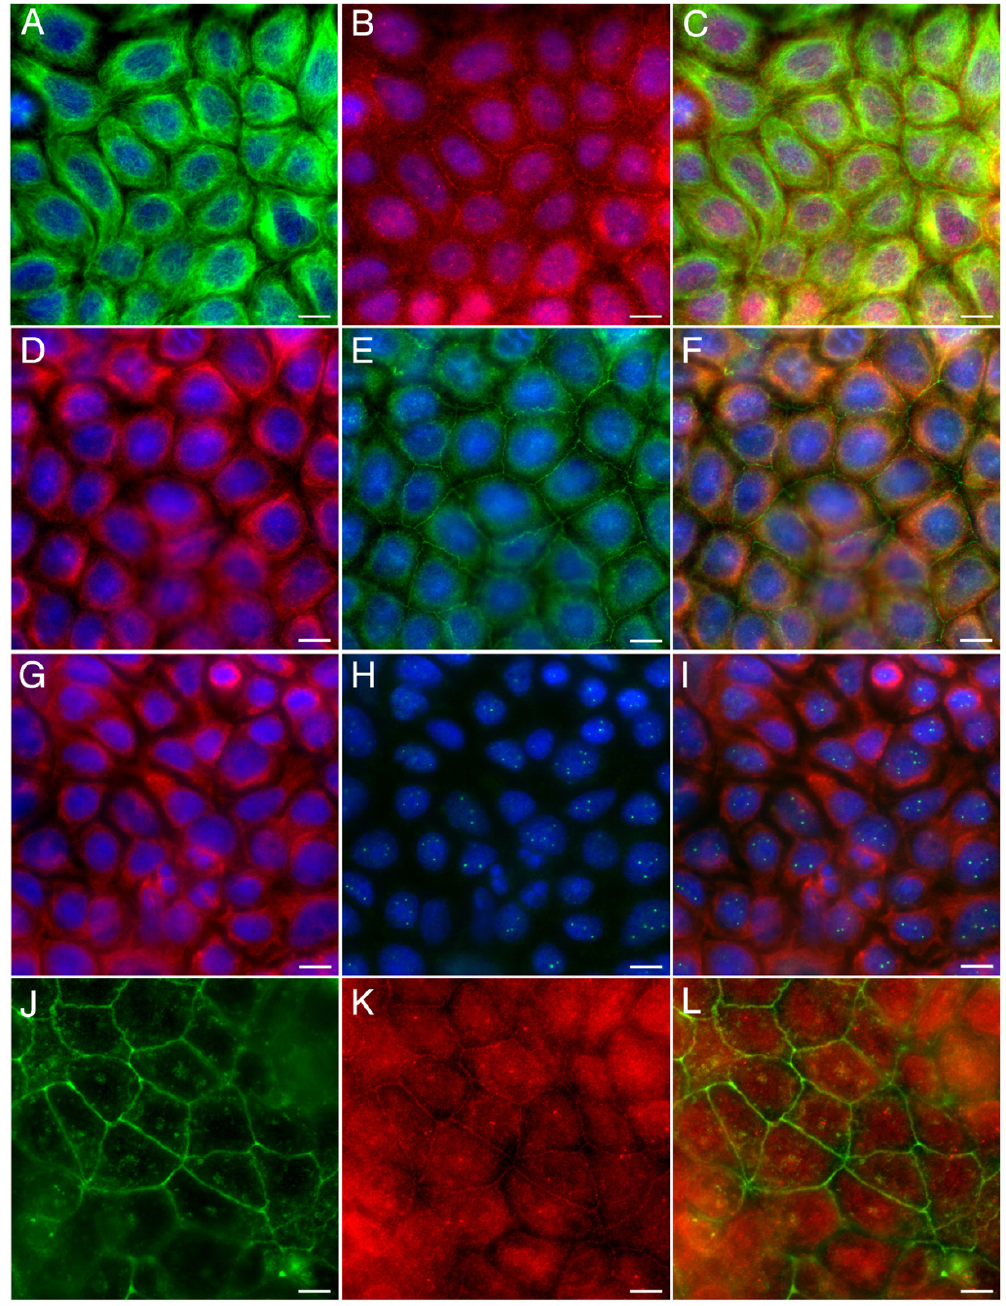
Figure 10 Junctional staining of the colon cancer cell line Caco-2 . Panels A-C. Confluent Caco-2 cells were co-immunostained with the polyclonal M-APC antibody and for microtubules. A microtubule-independent junctional localisation is seen. Tubulin green, APC red and DAPI blue. Panel C is a merged image. Panels D-F. Confluent Caco-2 cells immunostained using the mon- oclonal antibody ALI 12-28. Tubulin red, APC green and DAPI blue. Panel F is a merged image. Panels G-I. A monoclonal anti- body specific for the APC C-terminus shows no specific APC localisation, as would be expected with the truncated APC expressed in Caco-2 cells. Tubulin red, APC green and DAPI blue, panel I is a merged image. Panels J-L. Actin and APC co- staining in Caco-2 cells confirms the localisation of APC to junctional membranes. Actin green, M-APC red, panel L is a merged image. Bars = 10 µ